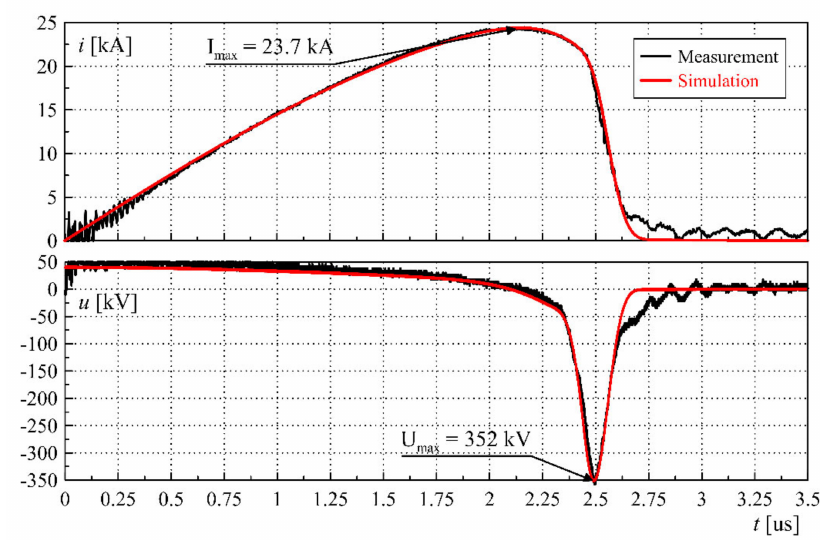
Figure 12. Representative comparison of the current i and voltage u on the forming coil waveforms obtained by measurements in a real PFS (in black) and by simulation (in red).